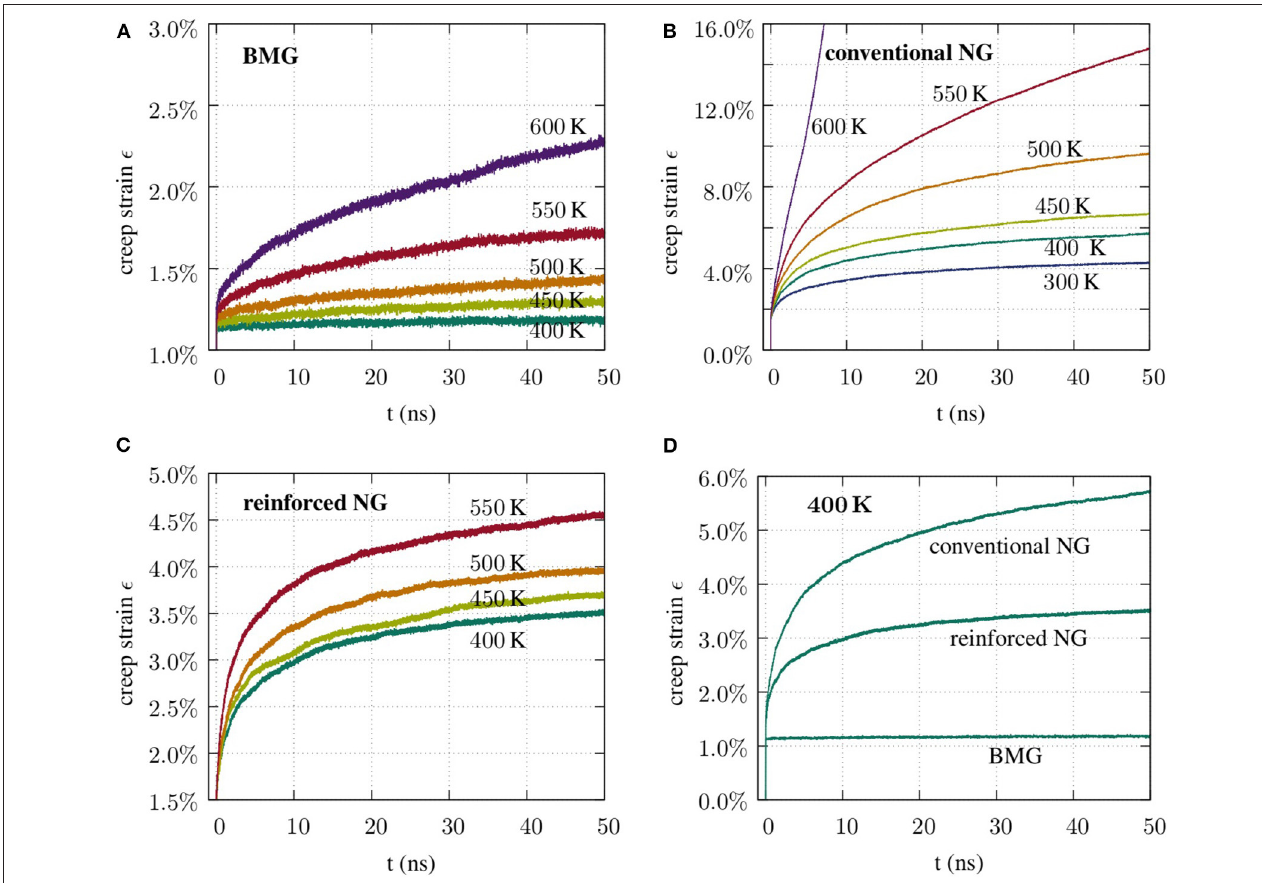
FIGURE 2 | Creep curves under uniaxial elastostatic loading conditions at 750 MPa of (A) a homogeneous Cu 64 Zr 36 MG, (B) a conventional NG with nominal composition Cu 64 Zr 36 , and (C) an interphase reinforced NG-composite. (D) For better comparison the 400 K creep curves of each sample type are shown in the same